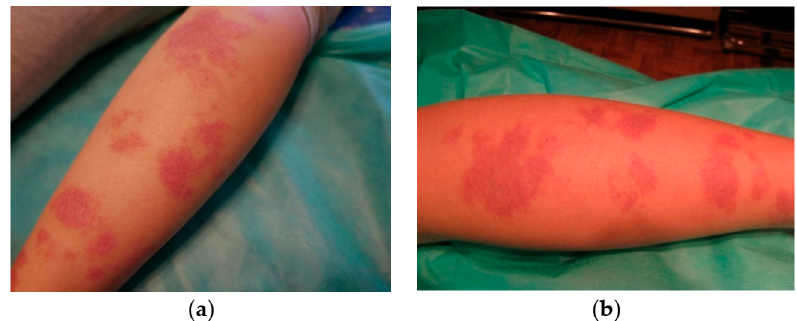
Figure 3. Pink PWS on legs with very poor results (estimated at 2 points) following therapy: ( a ) before treatment and ( b ) after treatment.